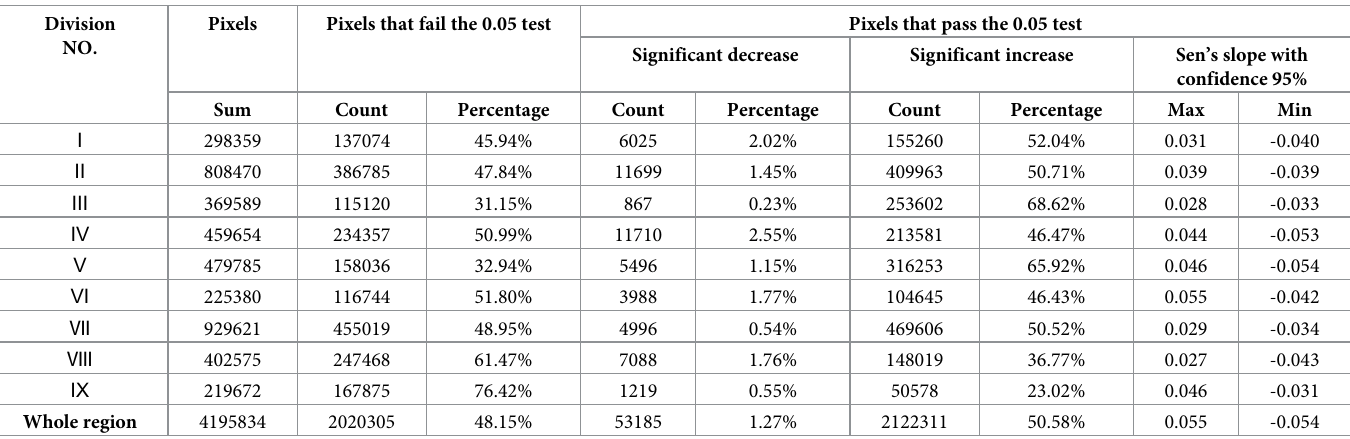
Table 5. Statistical results of NDVI variations trend Pixels of Northeast China. Division